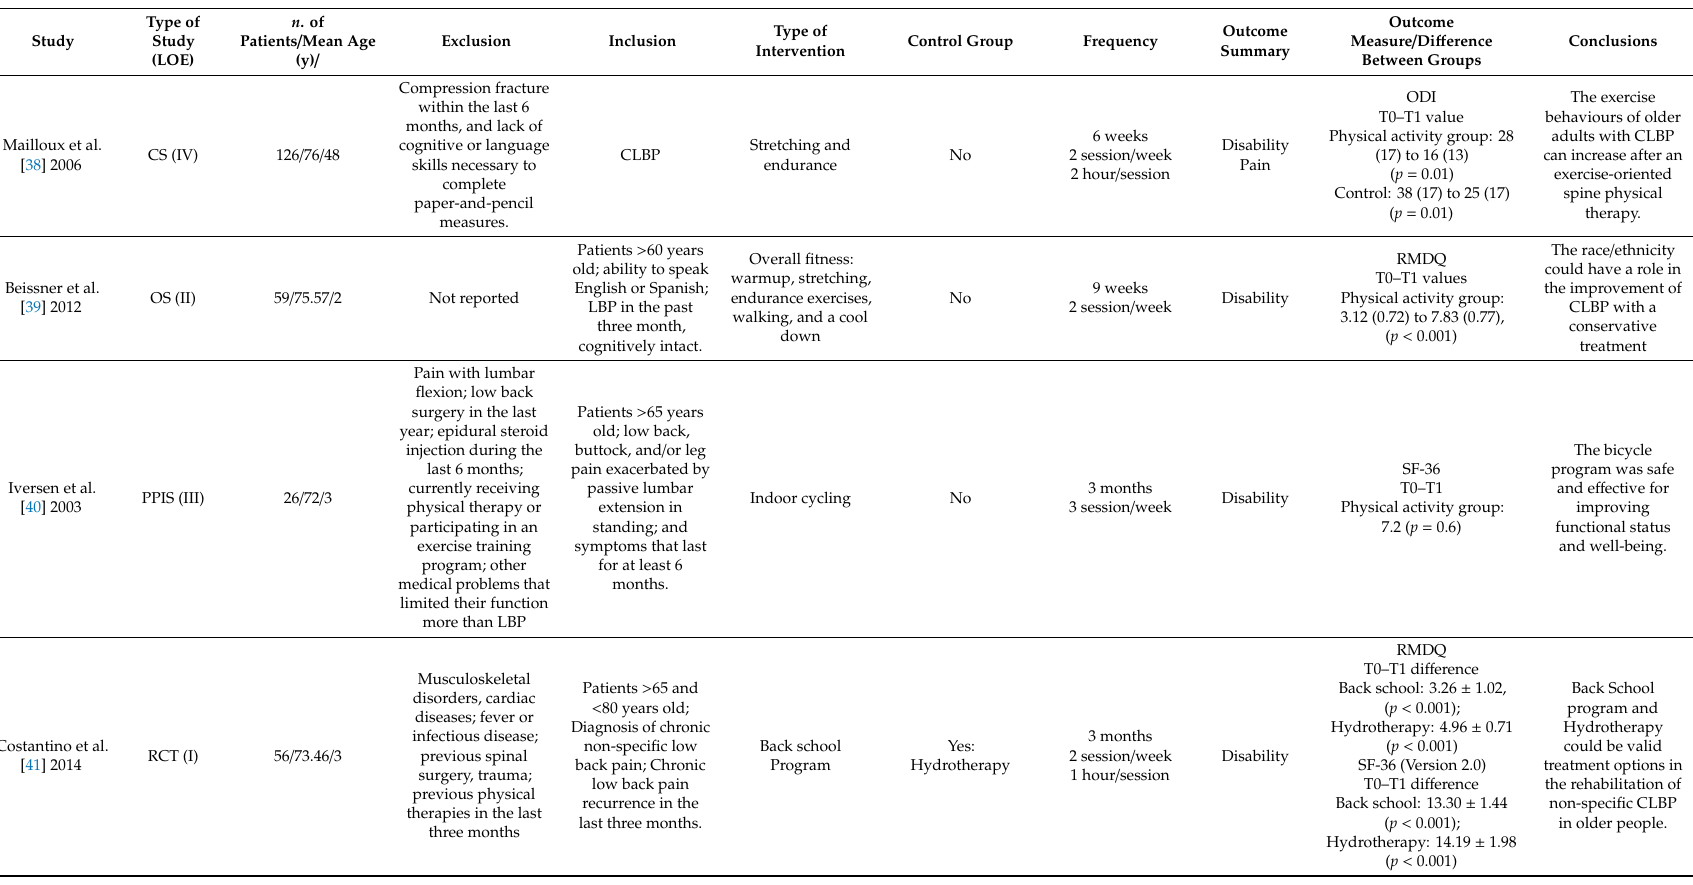
Table 5. Characteristics of the included